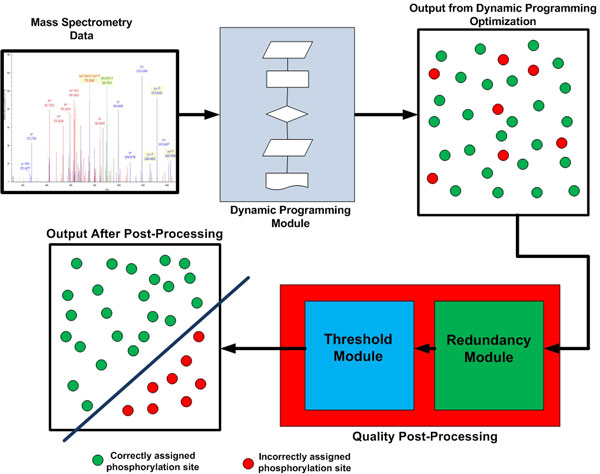
Flow diagram for PhosSA algorithm. Mass spectrometry data are fed into the dynamic programming module. The dynamic programming module output is the optimal assignment for each peptide, regardless of the overall quality of match. To sort the assignments by quality of match, a quality post-processing is used. The quality post-processing uses two additional criteria (Threshold (dCn) and redundancy) that allow discrimination between phosphorylation site assignment that are correctly vs. incorrectly assigned.